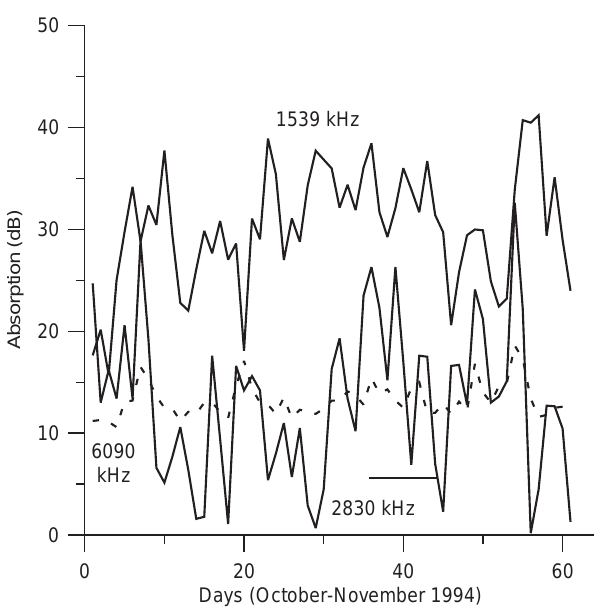
Fig. 5. Absorption at 1539 kHz ( solid line ), 2830 kHz ( solid line ) and 6090 kHz ( dashed line ) during October–November 1994 (days 1–61). Short horizontal line, interval of the CRISTA/MAHRSI